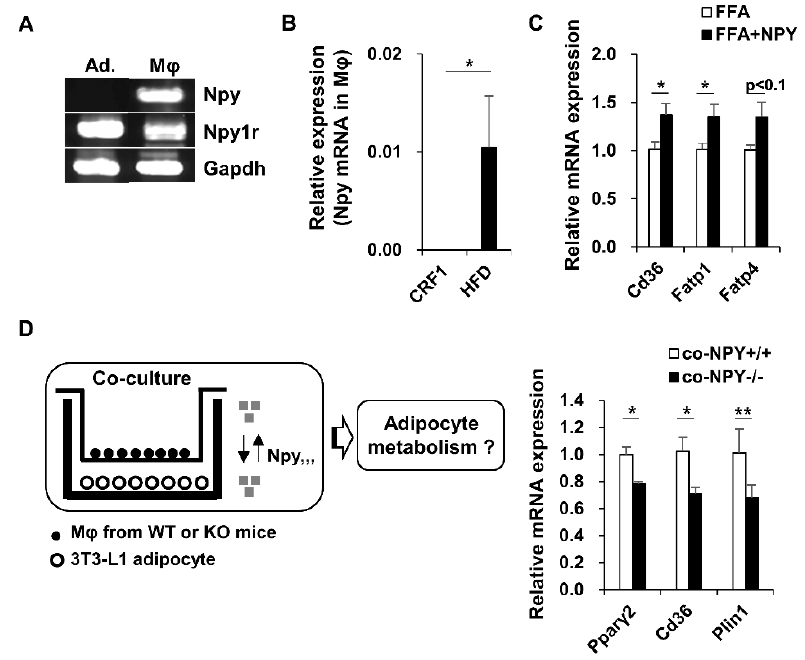
Figure 4. NPY is increased in macrophage in HFD-fed mice and involved in adipogenic and lipogenic genes expression in adipocyte. ( A ) mRNA expression of NPY and Y1R was measured by PCR in 3T3-L1 adipocytes (Ad.) and peritoneal macrophages (M ϕ ) from mice, ( B ) mRNA expression of NPY in peritoneal macrophage from mice-fed CRF1 and HFD, ( C ) Differentiated 3T3-L1 adipocytes were treated with NPY and FFA (500 µ M Palmitate), then analyzed mRNA expression of fatty acid transporters. ( D ) Differentiated 3T3-L1 adipocytes were co-cultured with peritoneal macrophages from WT and KO mice, then analyzed mRNA expression of adipogenic and lipogenic genes. All data are presented as the mean ± SEM ( n = 4 –6 per group), Student’s two -tailed t test, * p < 0.05, ** p < 0.01.